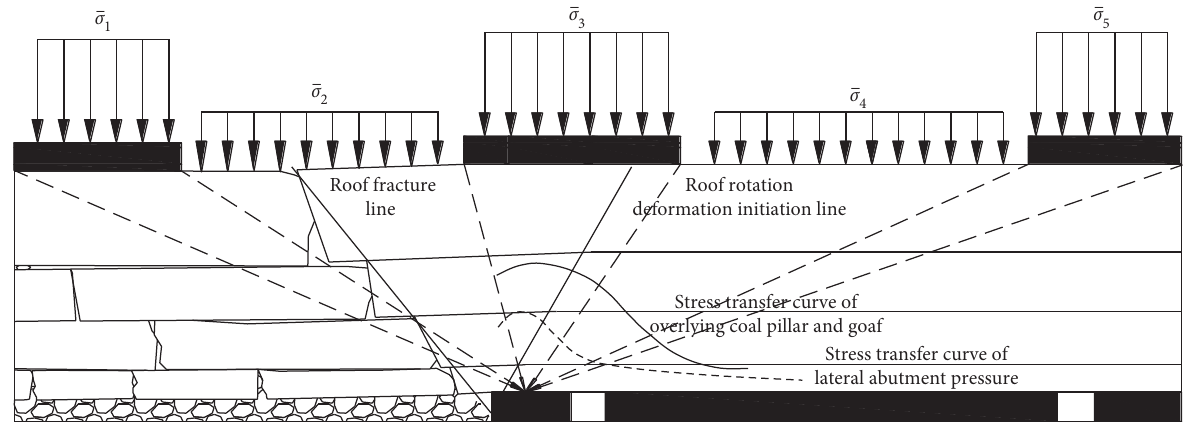
Figure. 4: Model of stress calculation in the gob-side roadway under overlying coal